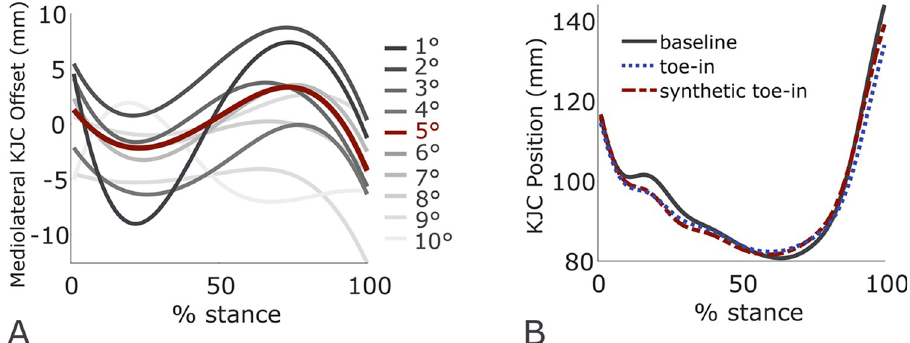
Fig 3. Synthetic gait generated via learned patterns. At each toe-in angle from 1˚ to 10˚, all subject trajectories for the foot center of pressure and knee joint center (KJC) were binned, averaged, and fit with a spline. (A) At a given toe- in angle, the trajectory represents the positional offset from baseline gait. (B) Here, knee joint center position in the mediolateral direction was predicted for a representative subject with a 5˚ toe-in angle by adding the learned offset to the baseline